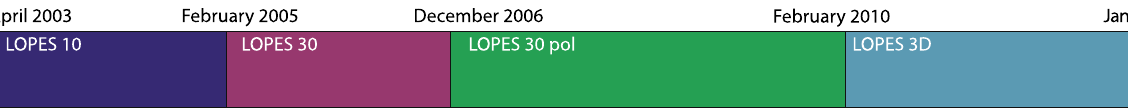
ment (LOPES 30 pol). Finally, all antennas were dismantled and 10 tripole antennas connected to the existing cables and DAQ infrastruc- ture (LOPES 3D). The results presented in this article are based on data acquired with the LOPES 30 and LOPES 30 pol